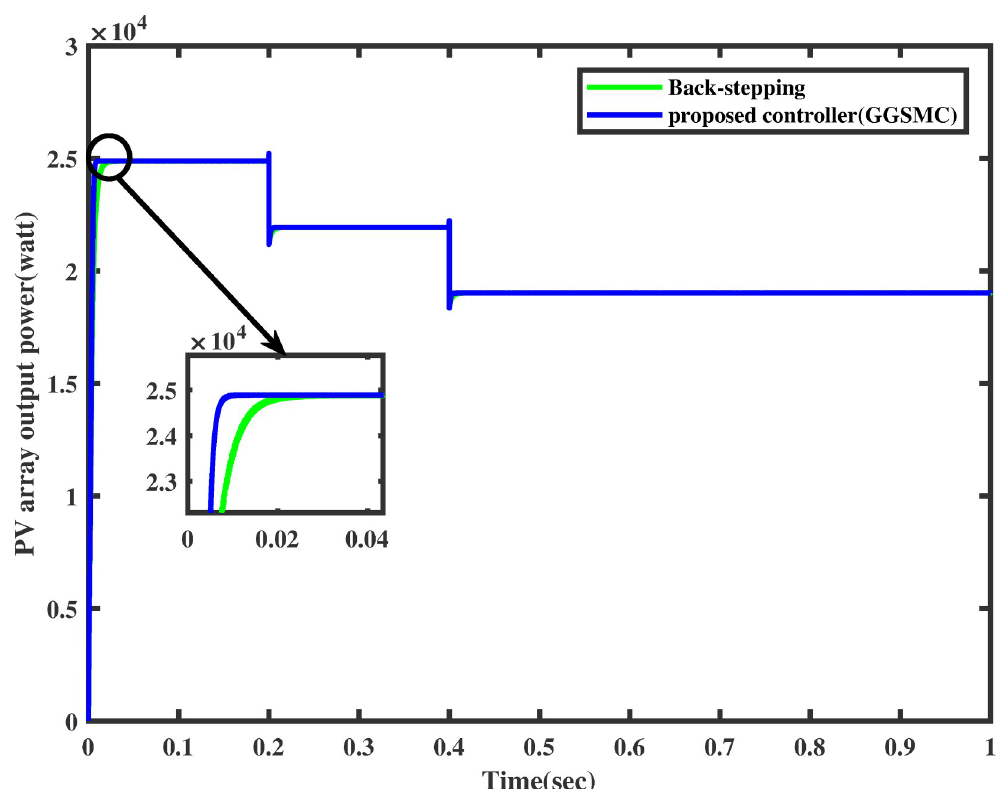
Fig 21. Comparison of PV array output power under varying